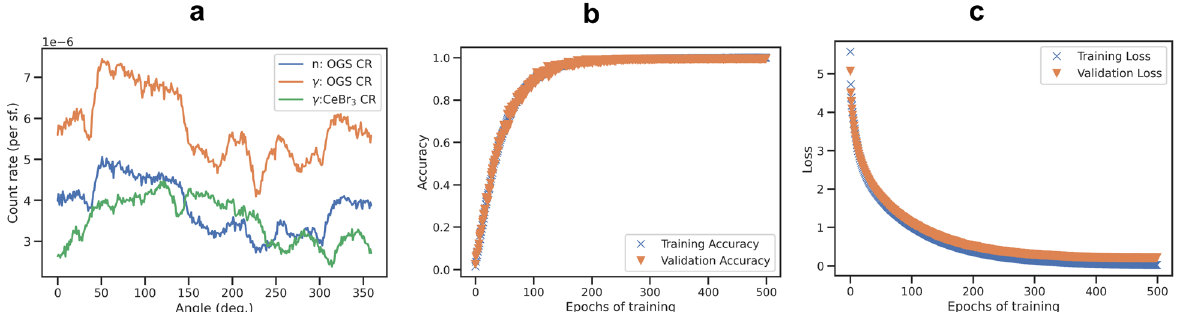
Figure 8. ( a ) Example of training data for neutron and photon interactions per spontaneous fission per source incidence angle in organic glass or CeBr 3 detectors. ( b ) Training and validation accuracy with training iterations (’epochs’). ( c ) Training and validation loss with